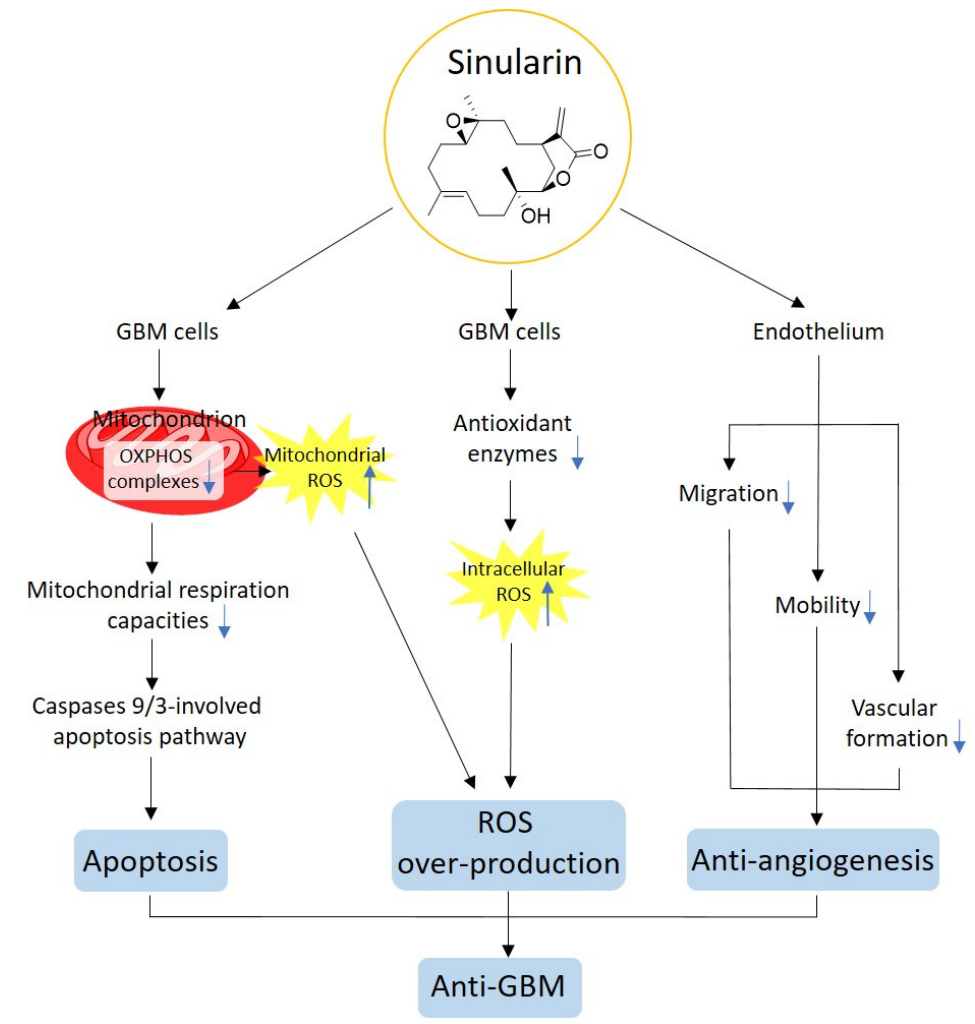
Figure 7. Proposed anti-cancer mechanisms of sinularin. GBM, glioblastoma multiforme; OXPHOS, oxidative phosphorylation; ROS, reactive oxygen species.